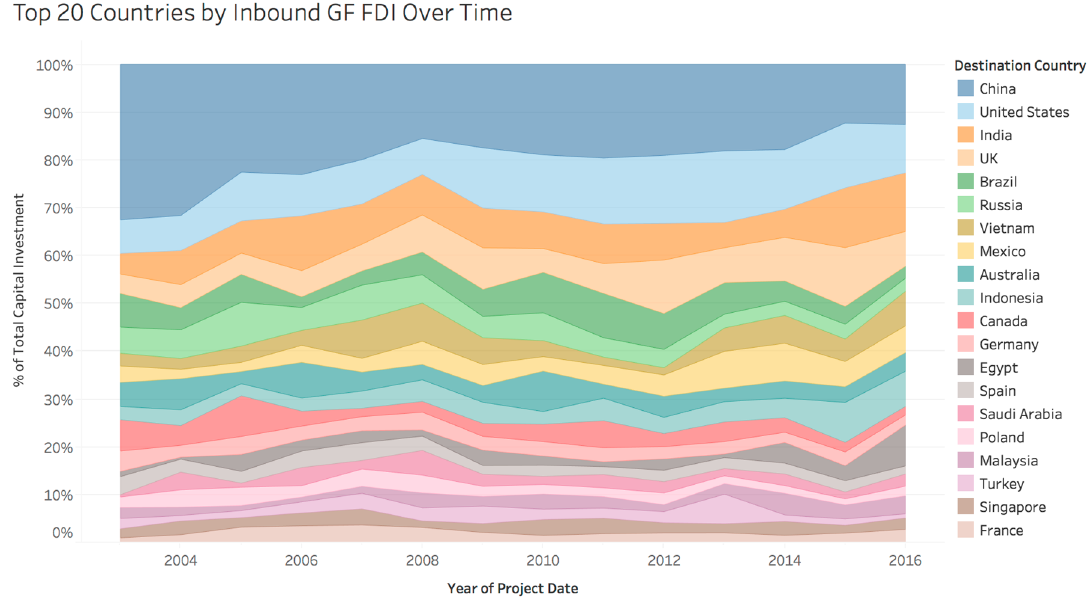
Figure 5. Top percent share of GF FDI in the top 20 countries (2003–2016). China, US, and India occupy ranks 1 to 3 in 2016.